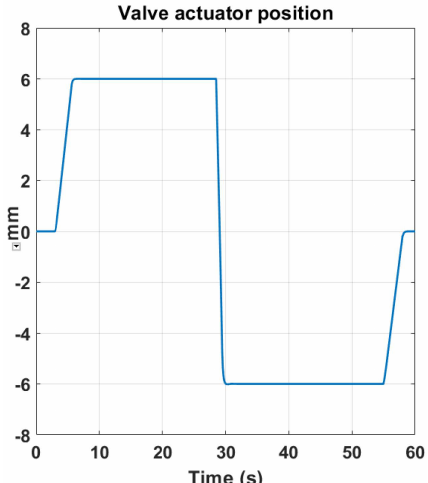
Figure 8. Variation versus time of the output signal of the Proportional Valve Actuator. During a cycle of rehabilitation exercising (60 s), the feed pressure of the pneumatic muscle and its axial contraction vary according to the graphs in Figures 9 and 10.